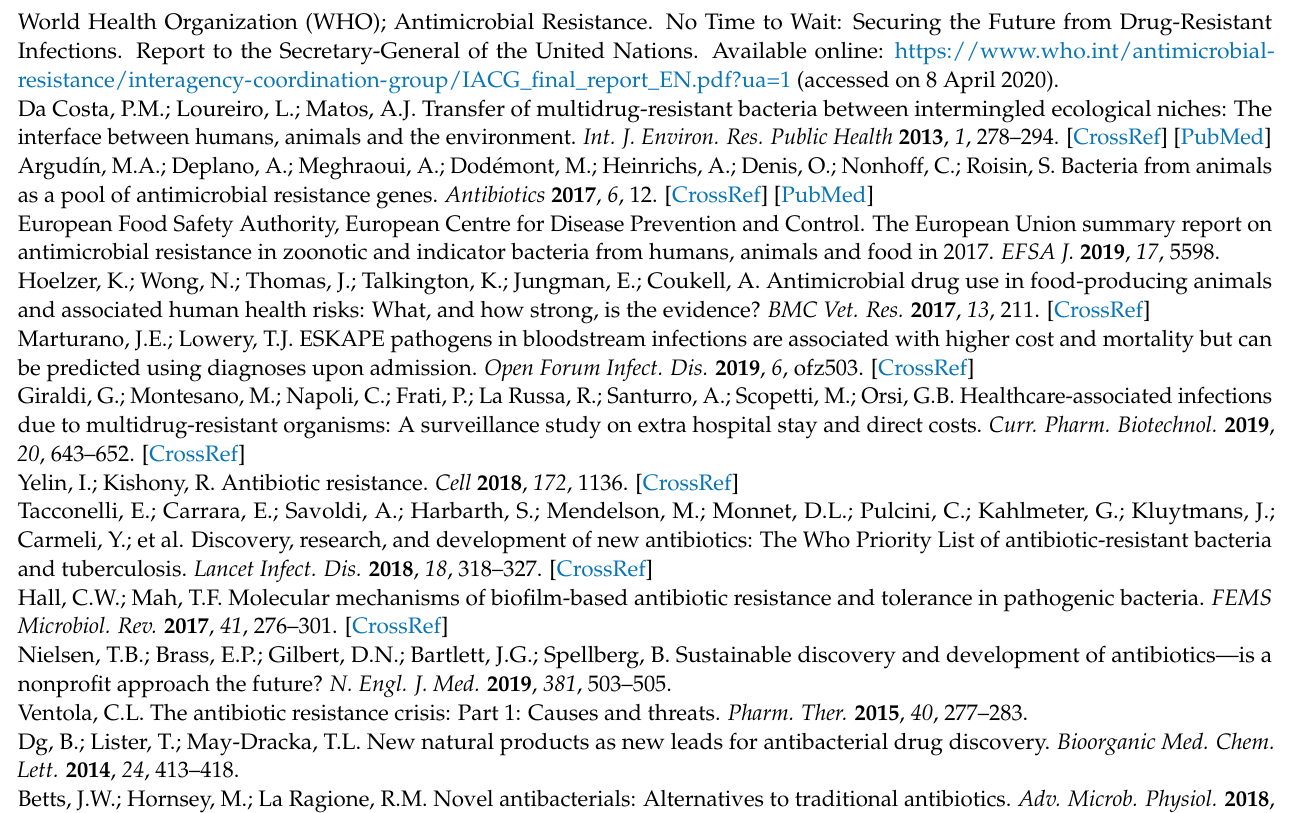
9-oxonerolidol, 2 (CDCl 3 , 400 MHz); Figure S9. 13 C NMR spectrum of 9-oxonerolidol, 2 (CDCl 3 , 100 MHz). Figure S10. COSY spectrum of 9-oxonerolidol, 2 (CDCl 3 , 400 MHz); Figure S11. HSQC spectrum of 9-oxonerolidol, 2 (CDCl 3 , 400/100 MHz); Figure S12. HMBC spectrum of 9-oxonerolidol, 2 (CDCl 3 , 400/100 MHz). Figure S13. NOESY spectrum of 9-oxonerolidol, 2 (CDCl 3 , 400 MHz); Figure S14. ESIMS spectrum of 9-oxonerolidol, 2 , recorded in positive modality; Figure S15. 1 H NMR spectrum of chiliadenol B, 3 (CDCl 3 , 400 MHz); Figure S16. 13 C NMR spectrum of chiliadenol B, 3 (CDCl 3 , 100 MHz); Figure S17. COSY spectrum of chiliadenol B, 3 (CDCl 3 , 400 MHz); Figure S18. HSQC spectrum of chiliadenol B, 3 (CDCl 3 , 400/100 MHz); Figure S19. HMBC spectrum of chiliade- nol B, 3 (CDCl 3 , 400/100 MHz); Figure S20. NOESY spectrum of chiliadenol B, 3 (CDCl 3 , 400 MHz); Figure S21. ESIMS spectrum of chiliadenol B, 3 recorded in positive modality. Table S1. 1 H and 13 C NMR data of 9-hydroxynerolidol ( 1 ); Table S2. 1 H and 13 C NMR data of 9-oxonerolidol ( 2 ); Table S3. 1 H and 13 C NMR data of chiliadenol B ( 3